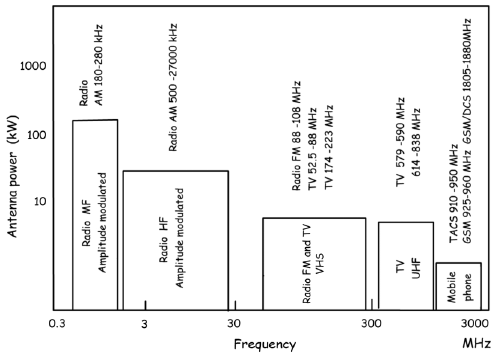
Fig. 11. Power emitted by the most common com- munication